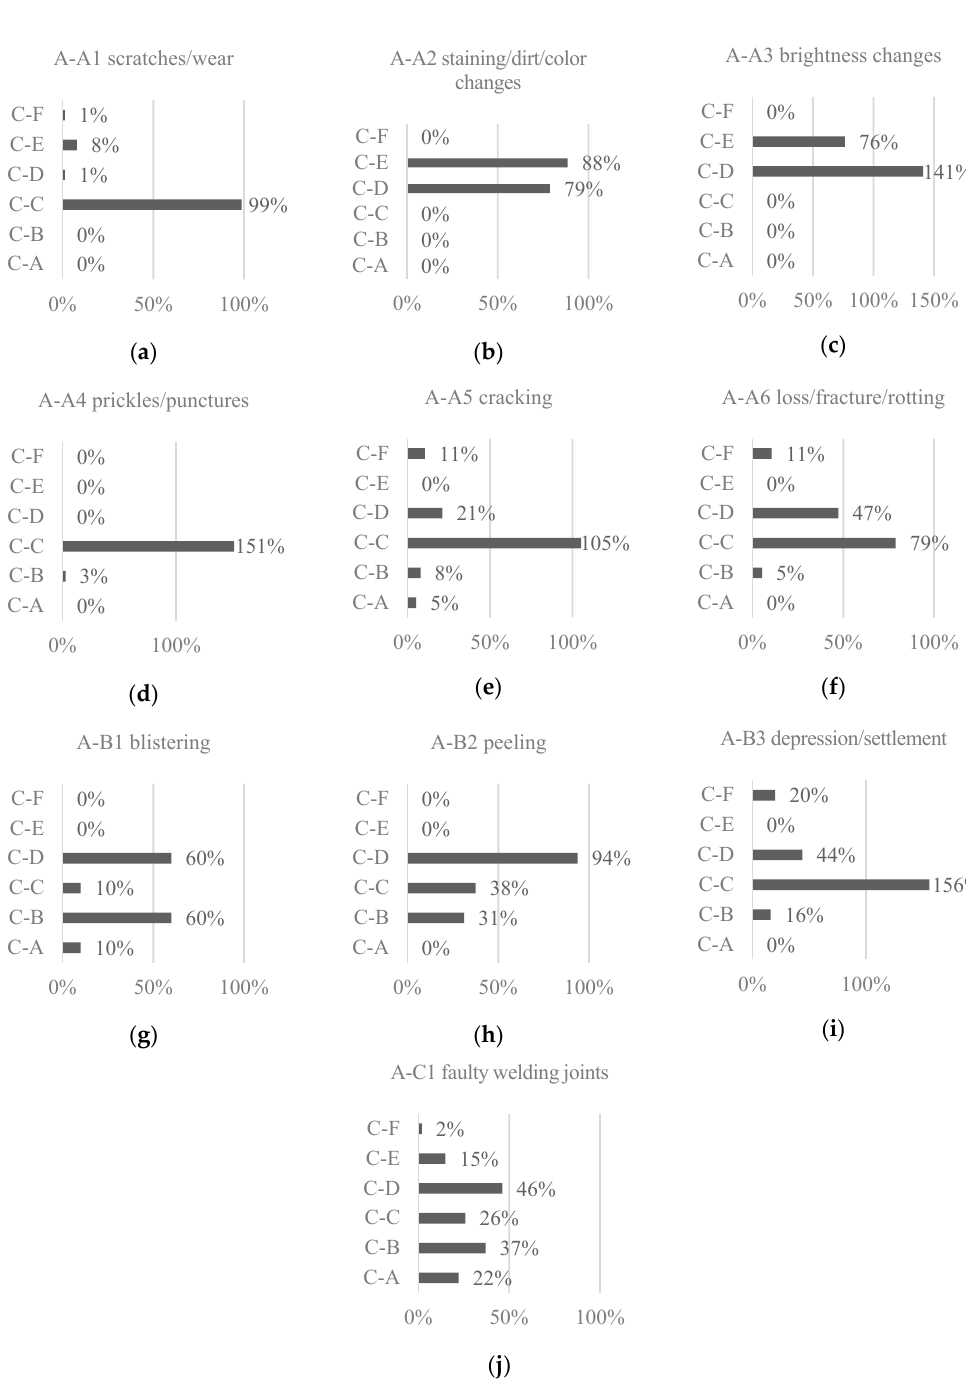
Figure 7. Contribution of each group of causes to each type of anomaly in the sample: ( a ) A-A1 scratches / wear; ( b ) A-A2 staining / dirt / color changes; ( c ) A-A3 brightness changes; ( d ) A-A4 prickles / punctures; ( e ) A-A5 cracking; ( f ) A-A6 loss / fracture / rotting; ( g ) A-B1 blistering; ( h ) A-B2 peeling; ( i ) A-B3 depression / settlement; ( j ) A-C1 faulty welding